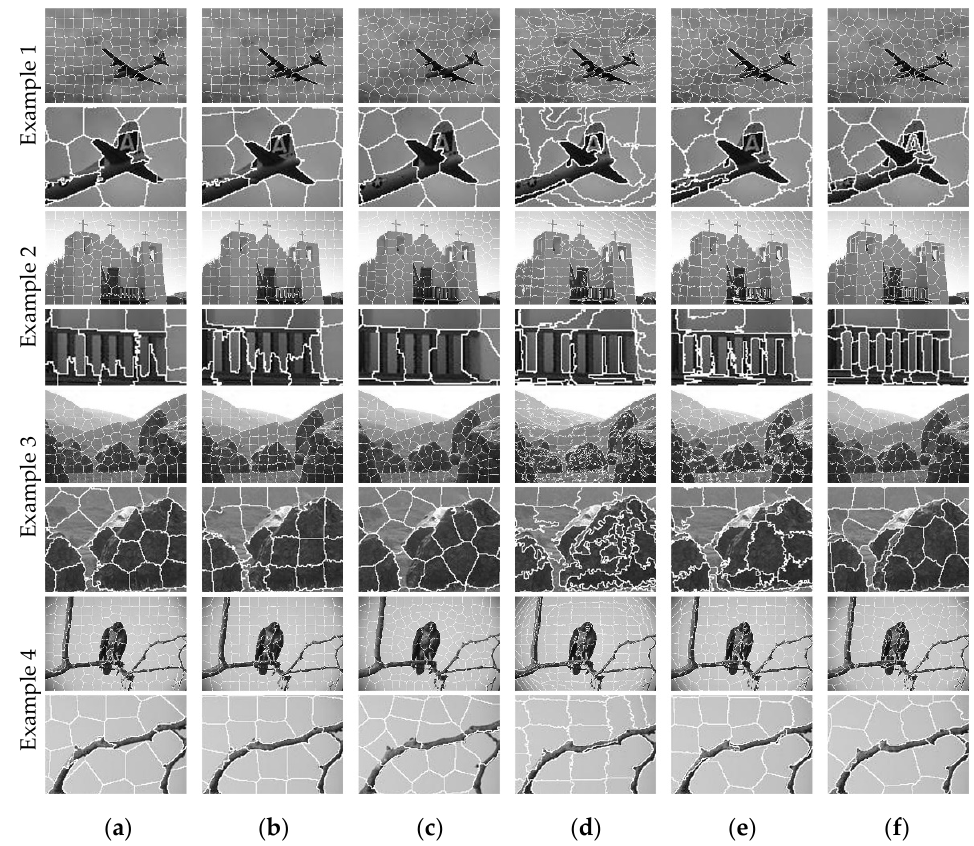
Figure 12. Visual comparison of superpixel segmentation among six different methods tested on the BSD500 dataset. Images in each column represent the results of: ( a ) SLIC; ( b ) SNIC; ( c ) LRW; ( d ) USEAQ; ( e ) CAS; and ( f ) our method. The expected number of superpixels was set as 150.